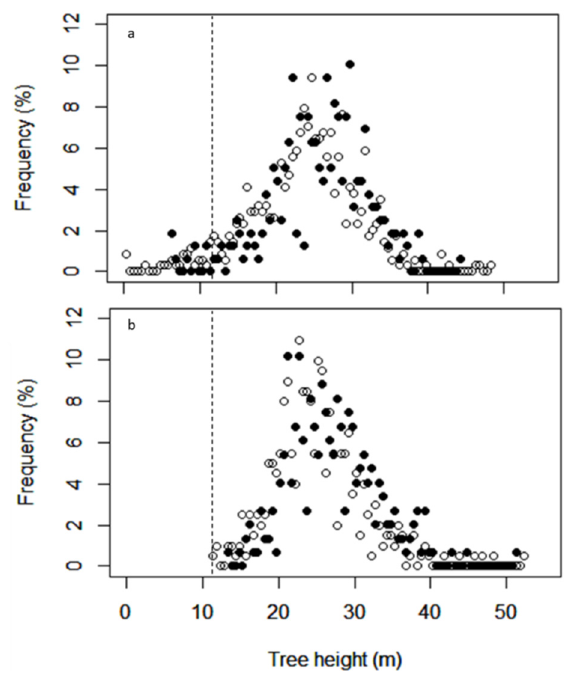
Figure 3. ( a ) Distribution of canopy height frequencies in the recovering logged (open symbols) and old-growth (solid symbols) blocks in the study area. The mean heights were 23.9 and 25.6 m, while standard deviations were 6.4 and 6.9, respectively. Panel ( b ) is the mean weighted height frequency of trees in the permanent field plots. Minimum height (11 m), noted by the vertical dashed lines, was dictated by the minimum size of trees measured in the plots [44]. Mean weighted height in plots classified as unlogged was 22.7 ± 5.8 m, while mean weighted height was 20.5 ± 5.8 m in the plots classified as